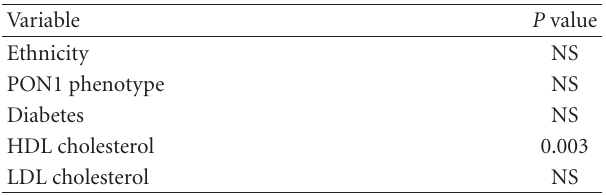
Table 4: Mixed model ANOVA analysis with arylesterase activity as the dependent